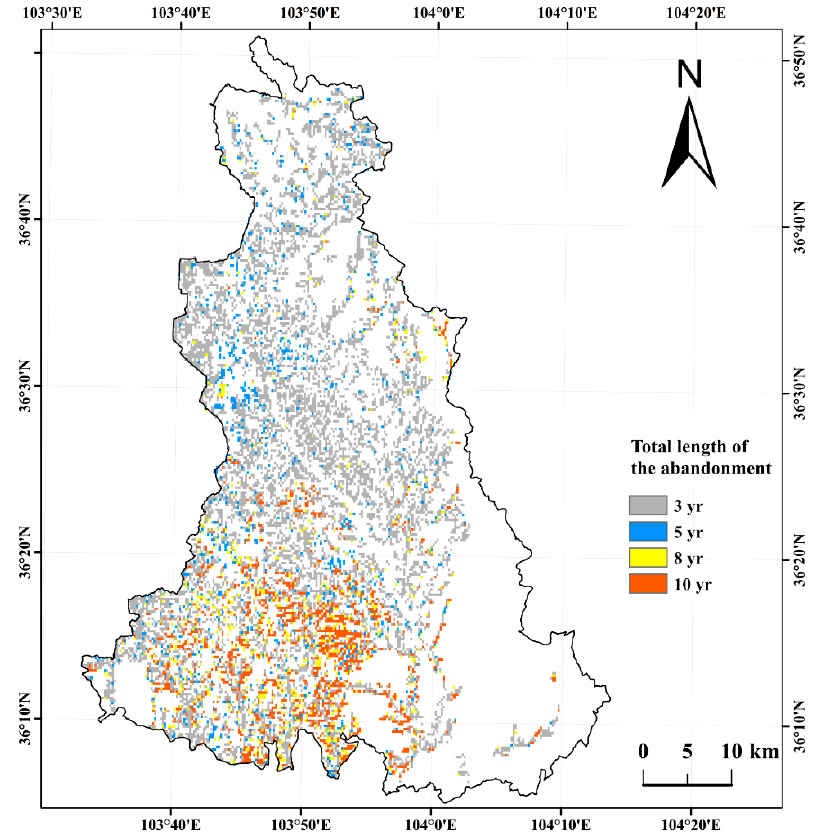
Figure 9. Distribution of total length of the abandonment (years) in Gaolan County. Table 4. Abandoned areas of different total length of abandonment in Gaolan County. Error! Reference source not found. presents the areas that were abandoned for dif- ferent lengths of time. The total abandoned area was 15,259.04 ha. The area of cropland Total Length of the Abandonment